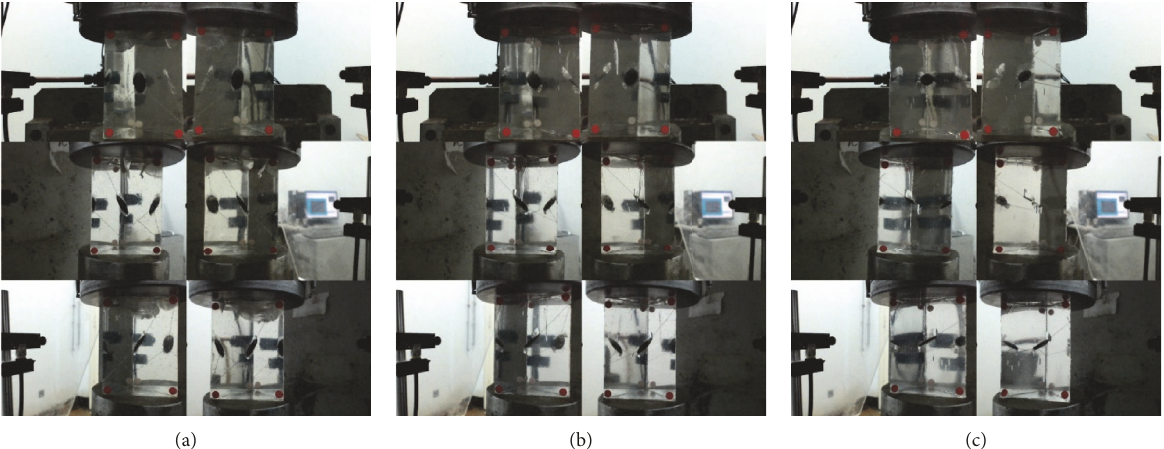
Figure 16: The testing process of the transparent sample under uniaxial compression. (a) Specimens with 30 degree, (b) specimens with 45 degree, and (c) specimens with 60